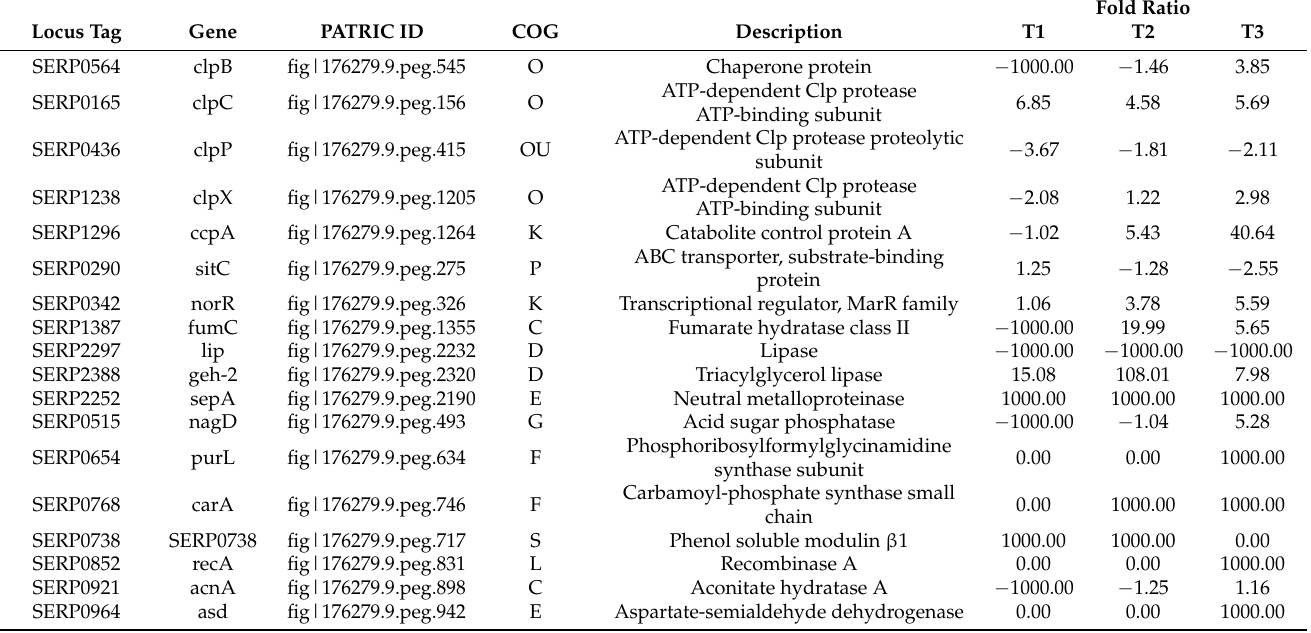
Table 3. Differentially expressed proteins associated with